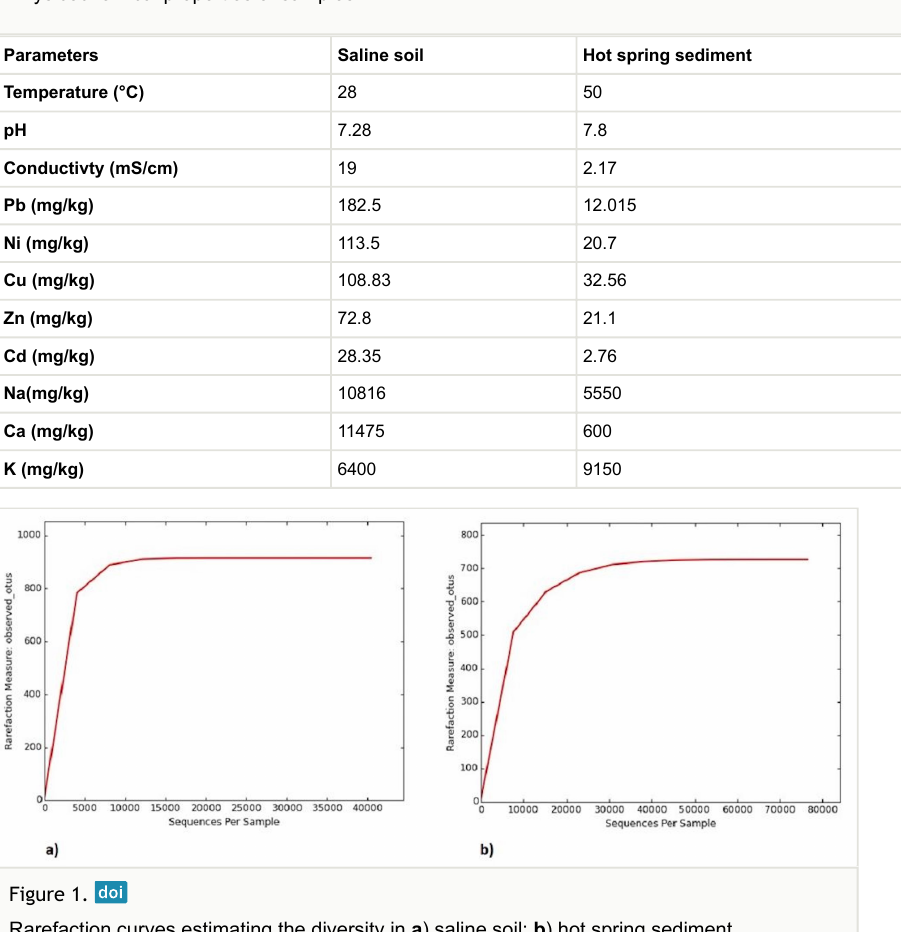
Physicochemical properties of samples.